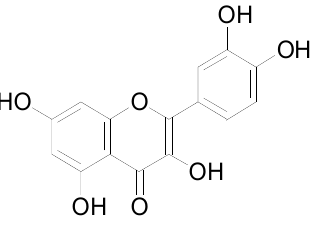
Figure 10. Quercetin, a flavonoid with the basic skeletal structure of flavonoids.